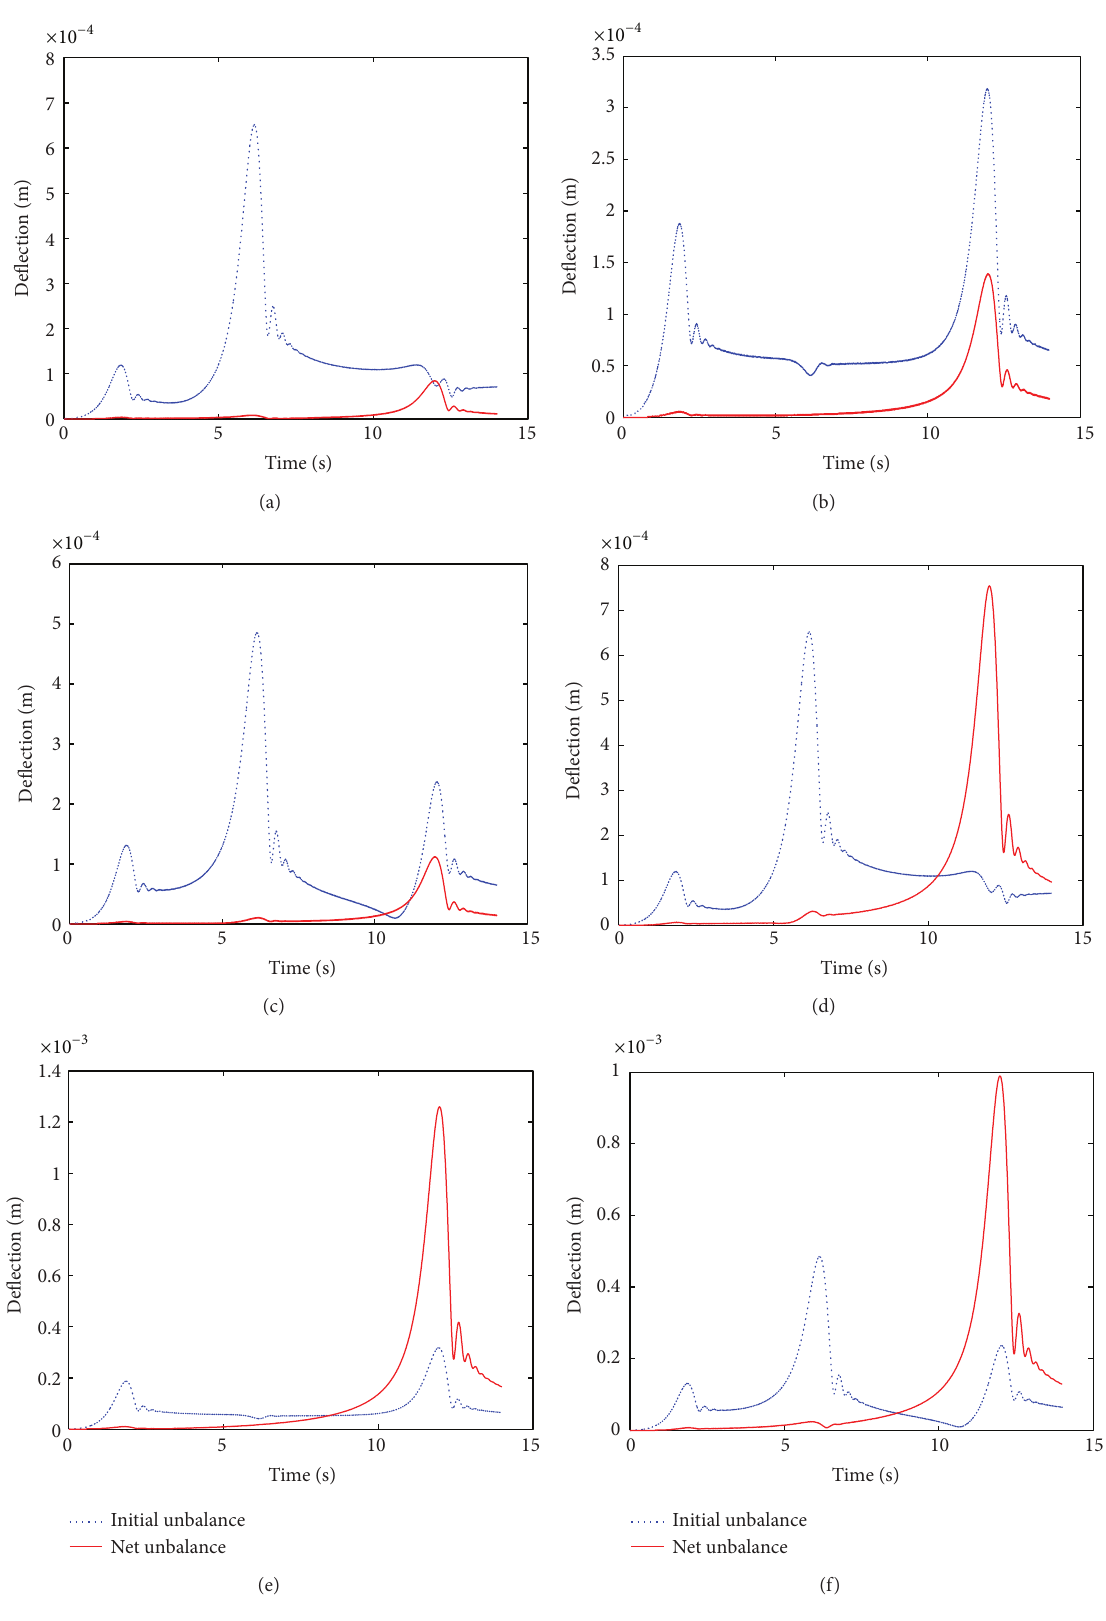
Figure 4: Lateral displacement responses versus speed of rotation with balancing (—) and without balancing ( ⋅⋅⋅ ). First three-order (a) disk 1, (b) disk 2, and (c) disk 3; first two-order (d) disk 1, (e) disk 2, and (f) disk